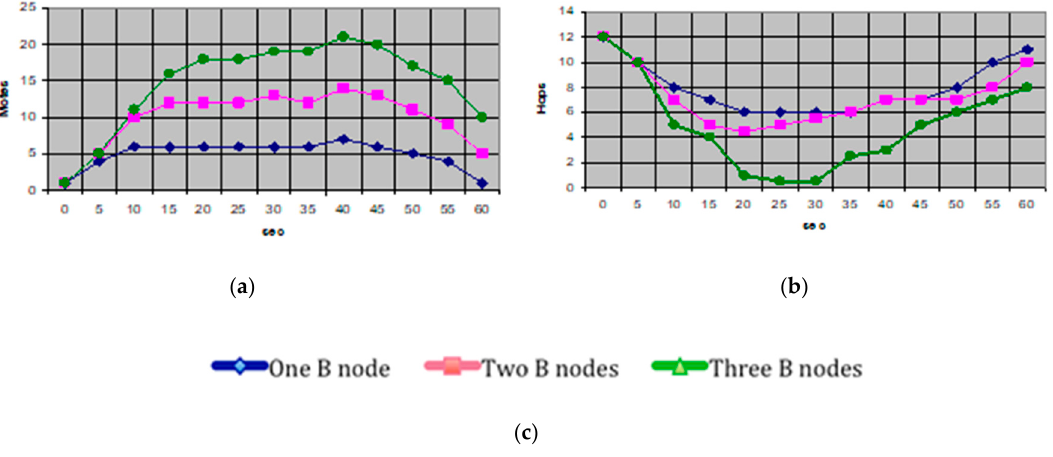
Figure 7. ( a ) Number of Hop 0 motes (left), ( b ) maximum number of hops (right) for nodes moving through the Cloud A area, ( c ) cases of one (diamonds), two (squares) and three (dots) moving Cloud B nodes.